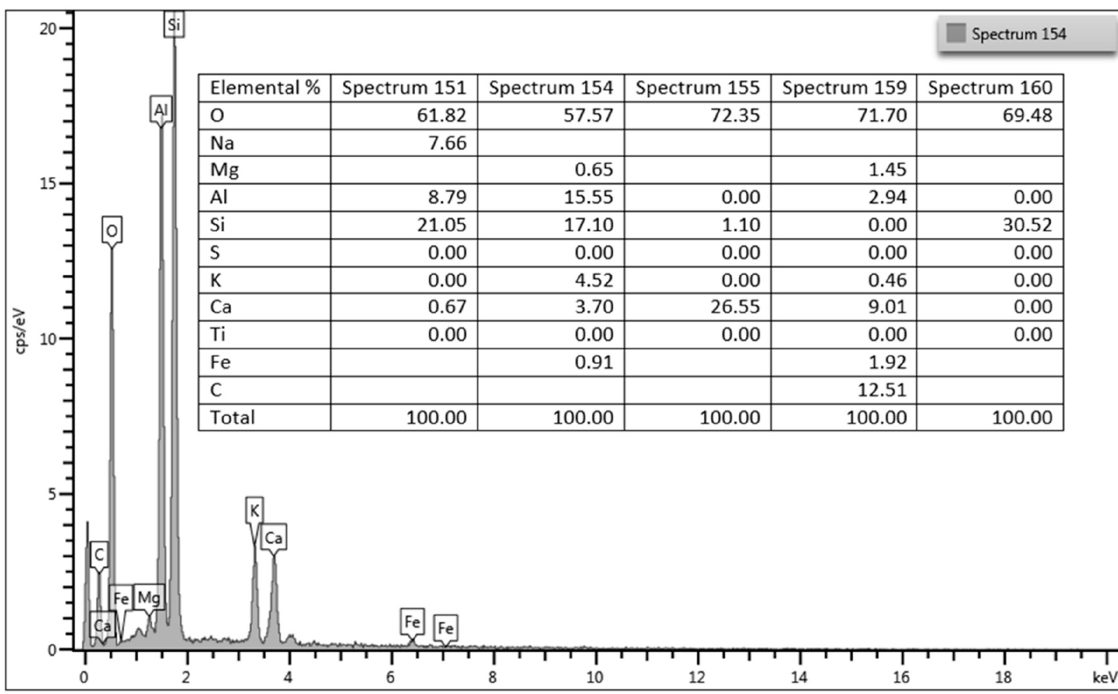
Figure A4. EDS analysis from the spectrum 88 of BFN mortar (the insert table is the % elemental composition of other spectrums).